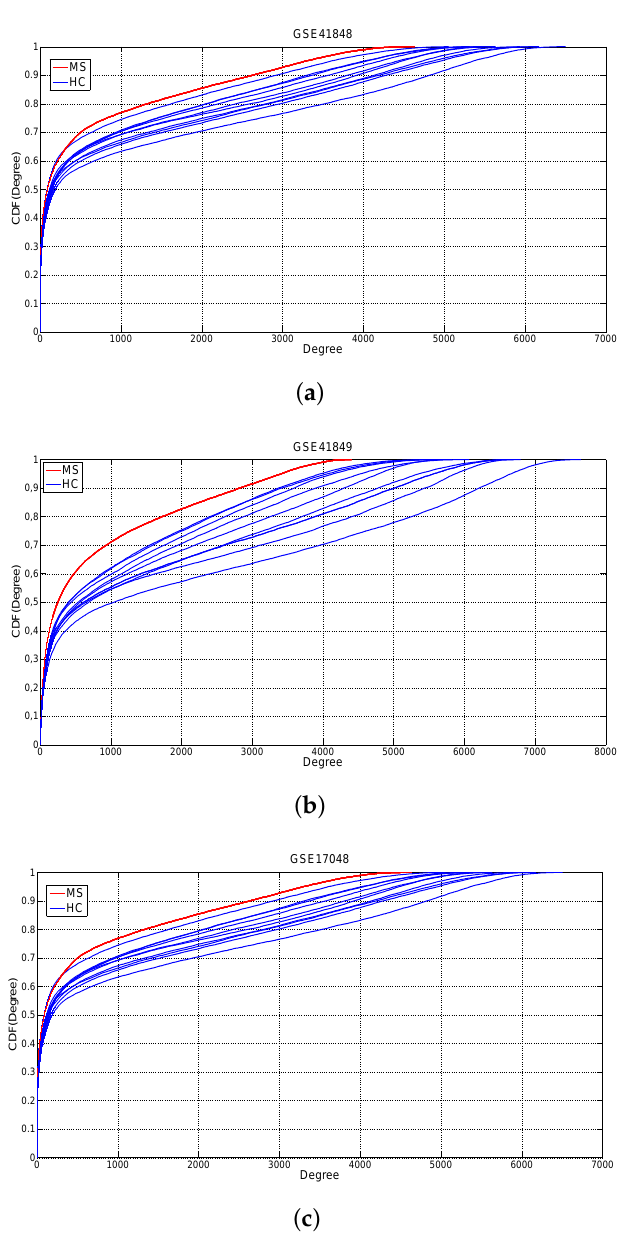
Figure 2. Cumulative distribution functions of the gene degree. Comparison between HC (blue color) and MS (red color) specimens of whole-blood by using the GSE41848, GSE41849 and GSE17048 GEO datasets. ( a ) GSE41848; ( b ) GSE41849; ( c )